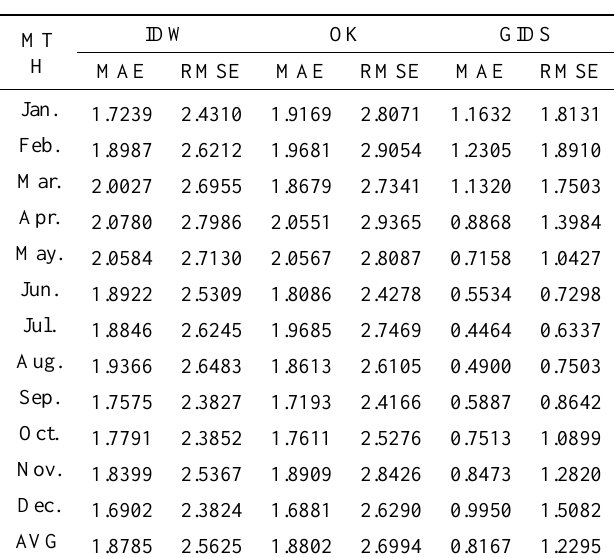
Table 1. Experimental results of GIDS, IDW and OK ( ℃